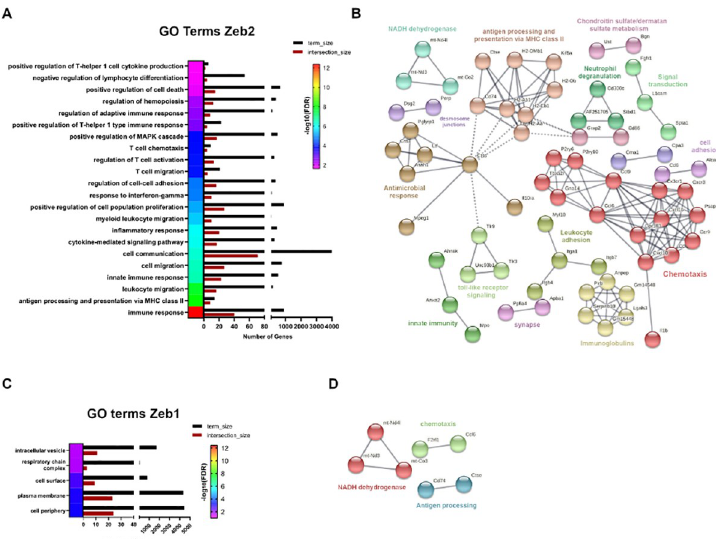
Fig 7. RNA-seq analysis of LSK-enriched populations reveals both common and unique immediate early gene expression programs controlled by ZEB1 and ZEB2. (A) Associated GO terms with ZEB2-DEGs, obtained with the STRING database, using an FDR < 0.05). (B) Associated network analysis for ZEB2-DEGs, obtained with STRING database using highest confidence interaction scores (0.900) and clustered with an MCL inflation parameter of 3. (C) Same as (A) for ZEB1 DEGs. (D) Same as (B) for Zeb1 DEGs. Raw data behind panels are included in S3 Table . DEG, differentially expressed gene; FDR, false discovery rate; GO, gene ontology; LSK, Lin − Sca1 + cKit + ; RNA-seq, RNA